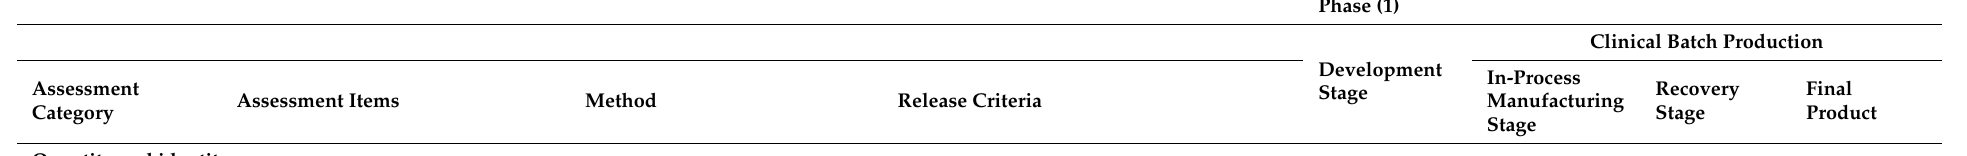
Table 4. Suggested QC panel of MSC-EVs at different stages of product development